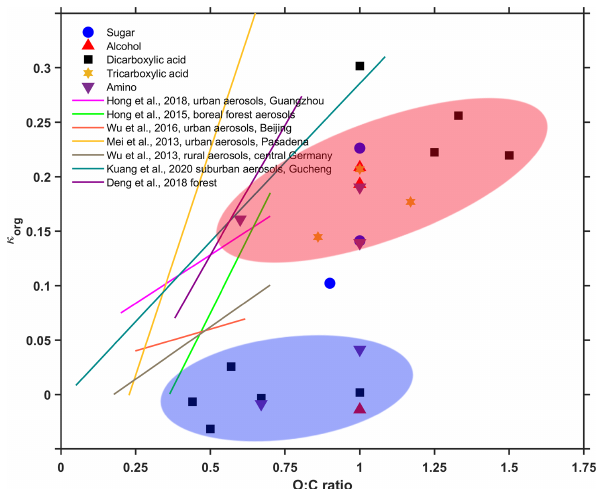
Figure 7. Correlation between O : C ratio and κ org and comparison with previous literature results. Blue and red shades represent the fitting of results of non-hygroscopic and more hygroscopic organ- ics,